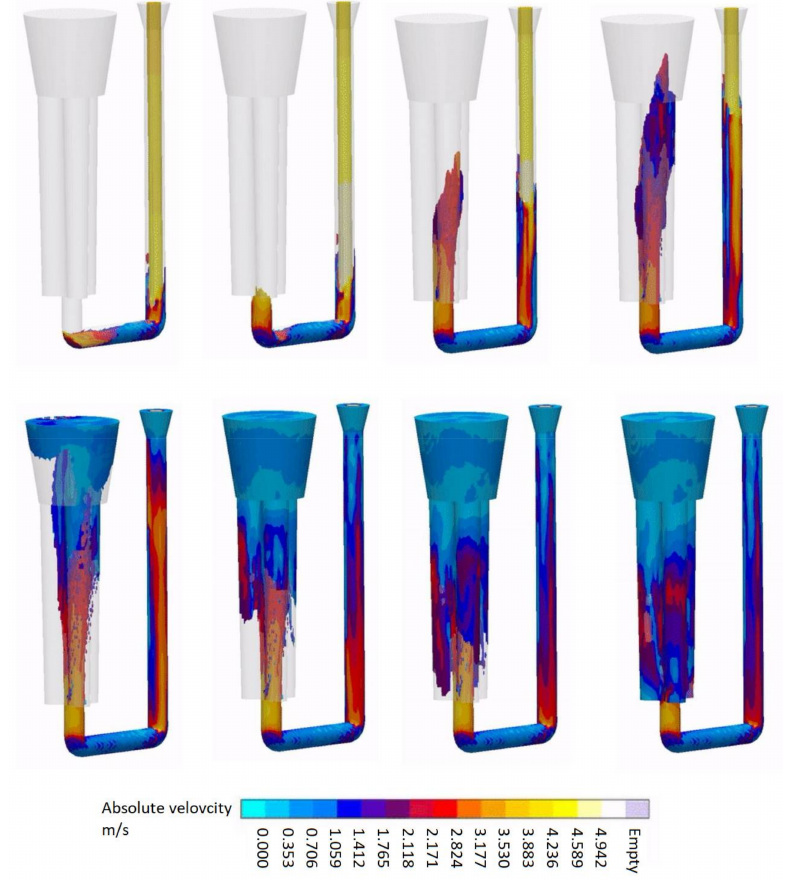
Figure 2. Reference geometry of the gating system pouring process; average filling time 2